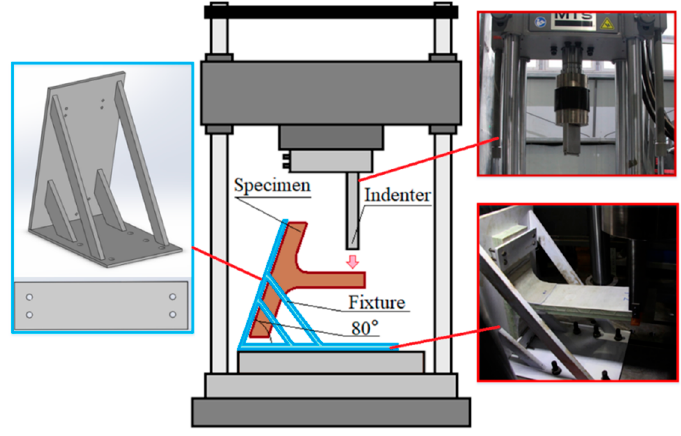
Figure 6. Experimental set-up.